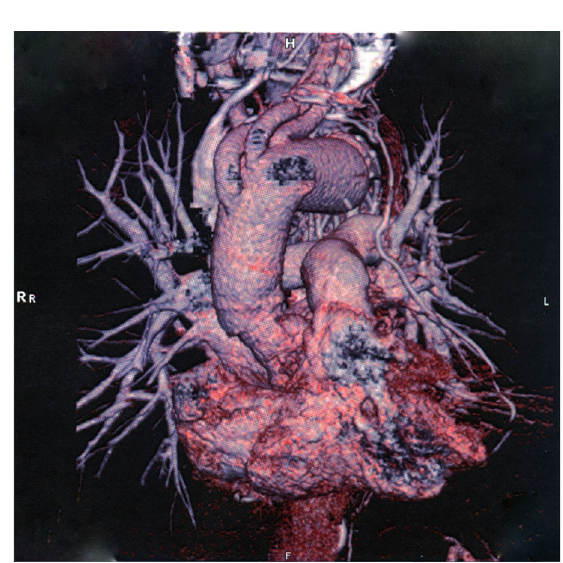
Fig. 3 – CT angiography 1 year post-operatively showed that the morphology of the reconstructed aortic root appeared normal without sign of aneurysm or dissection